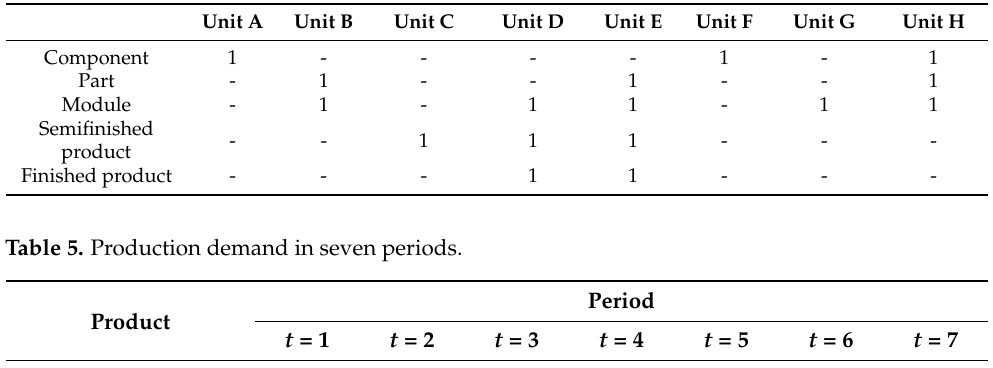
Table 4. Manufacturing relationship of materials between manufacturing units.